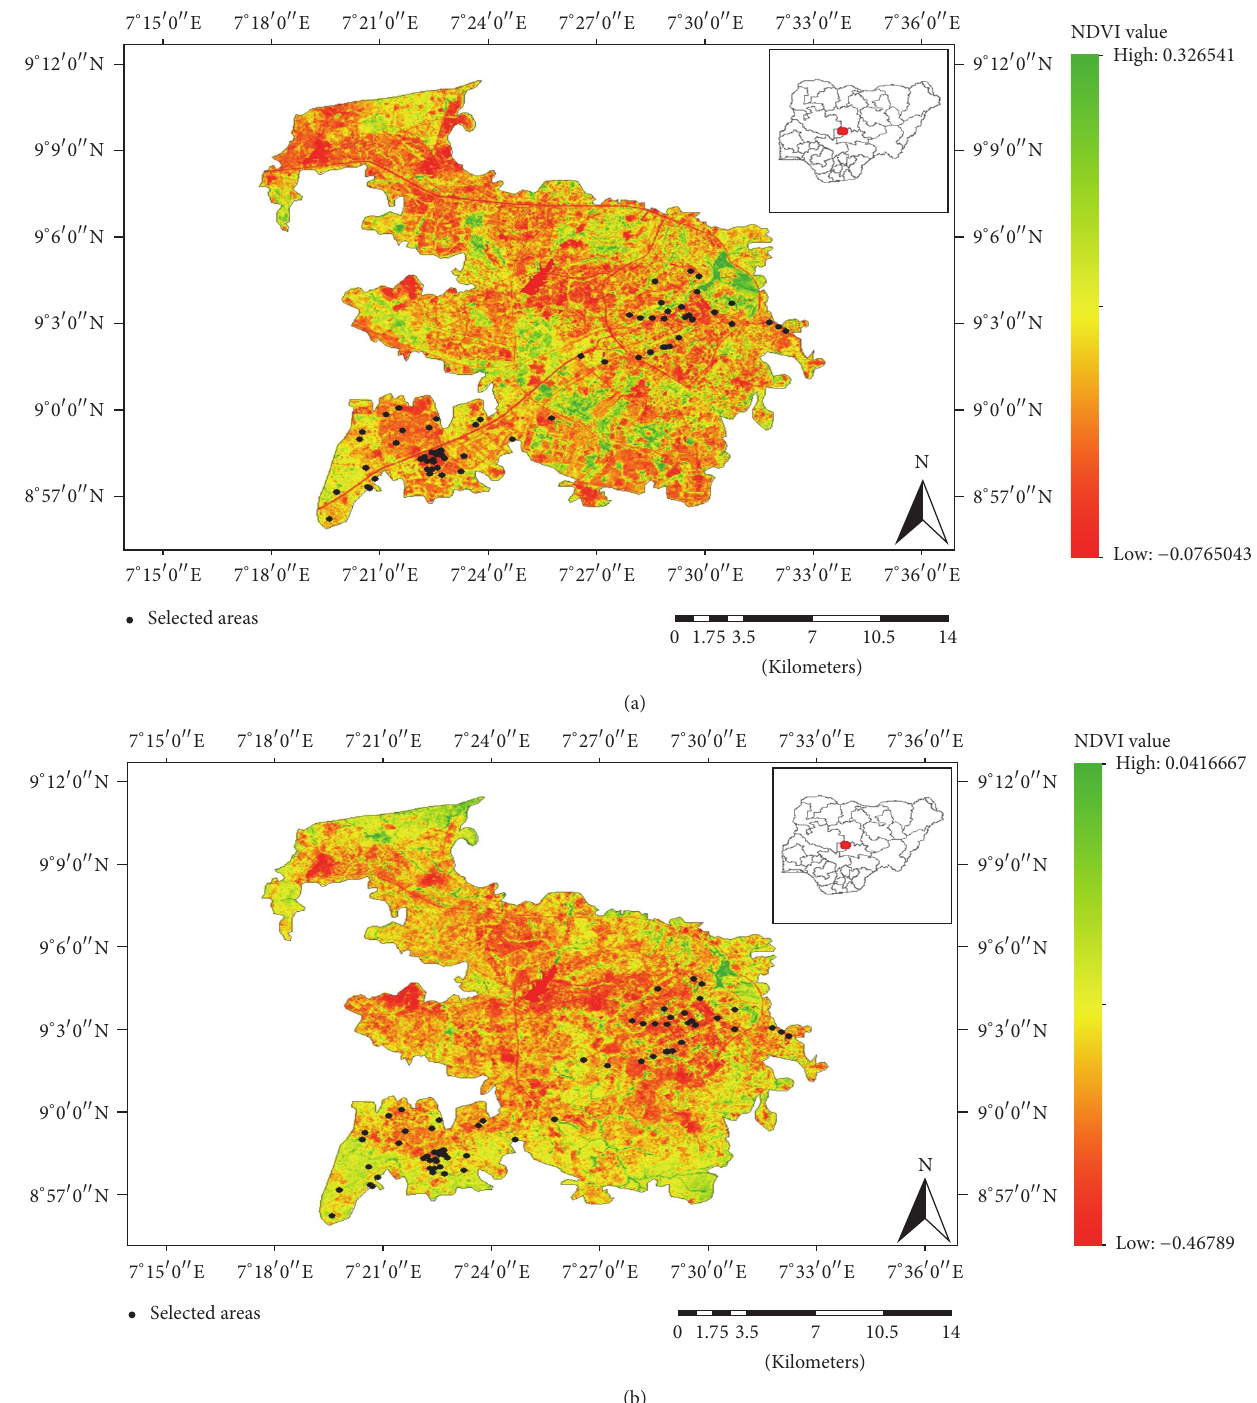
Figure 1: (a) Normalized Difference Vegetation Index (NDVI) map for Abuja for the year 2000 and sampling locations. (b) Normalized Difference Vegetation Index (NDVI) map for Abuja for the year 2015 and sampling locations.